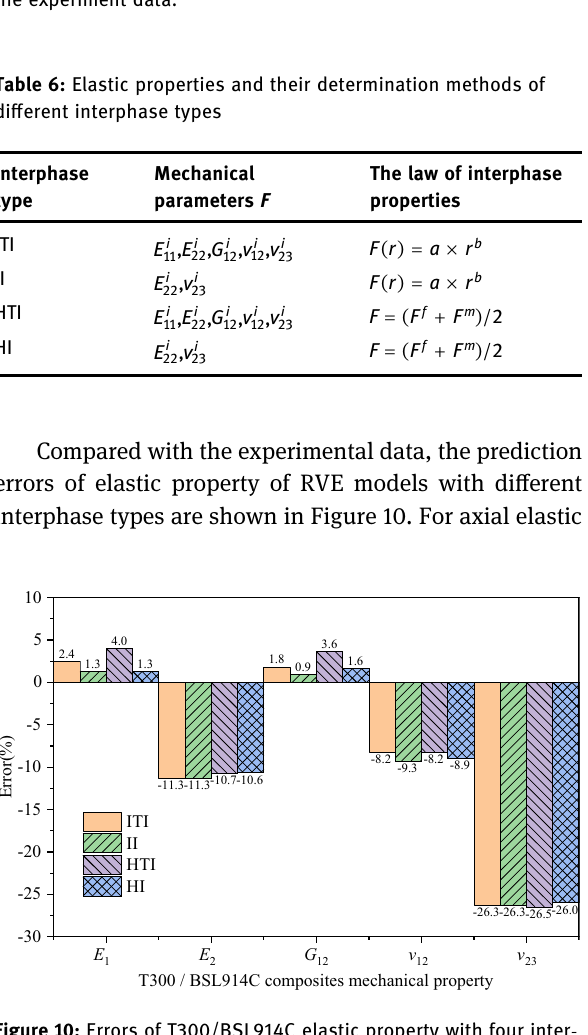
Figure 9: Comparison of errors in the prediction results of composite elastic properties by di ff erent calculation methods compared with the experiment data.